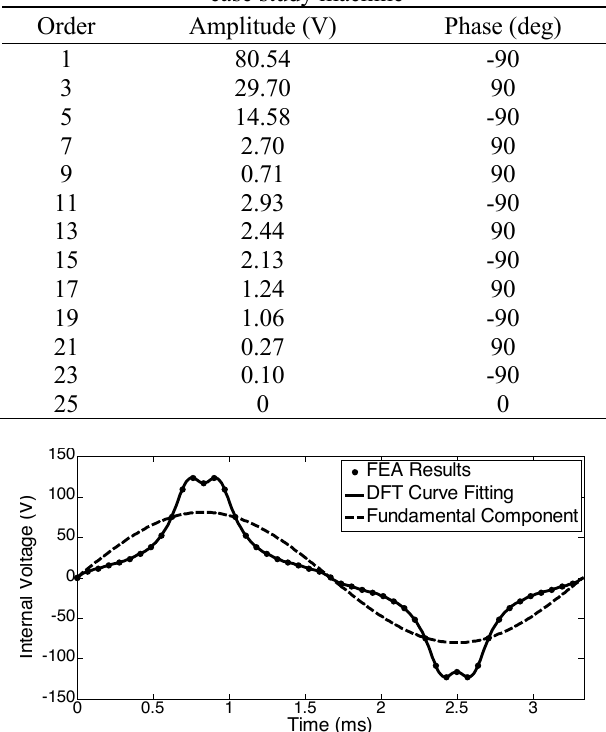
Table 5: Harmonics of the Internal Voltage of